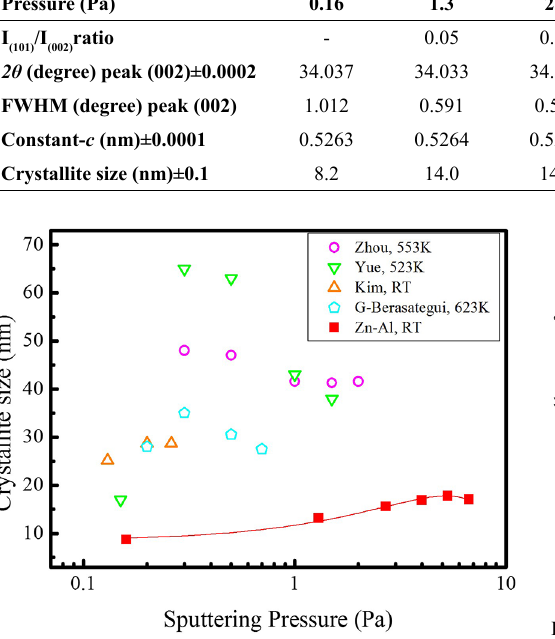
Figure 4. Crystallite size of the AZO films as a function of the sputtering pressure. For comparison, crystallite sizes obtained by Zhou et al. 32 , Yue et al. 20 , Kim & Kim 14 and G-Berasategui 10 are also shown.